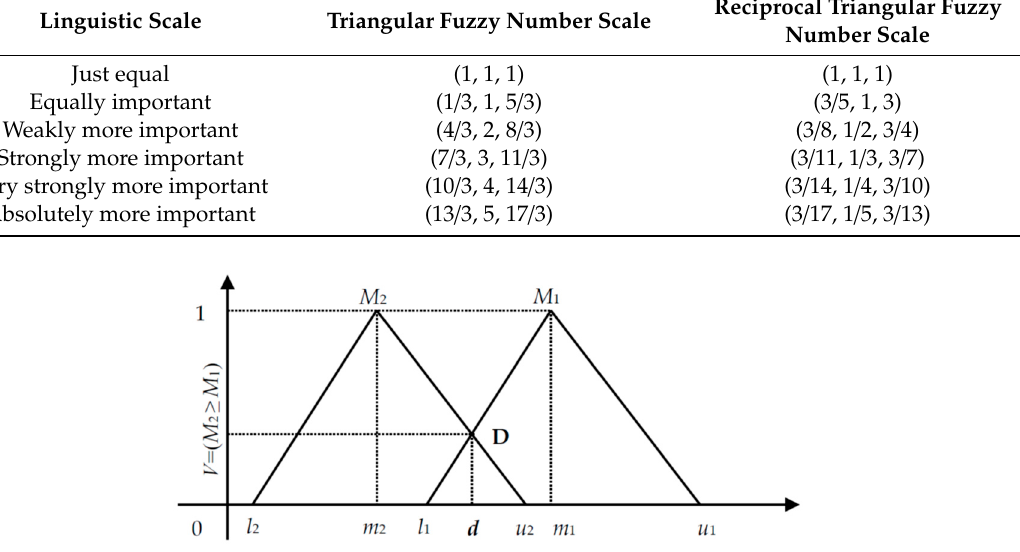
Figure 3. The intersection between M1 and M2. [87].